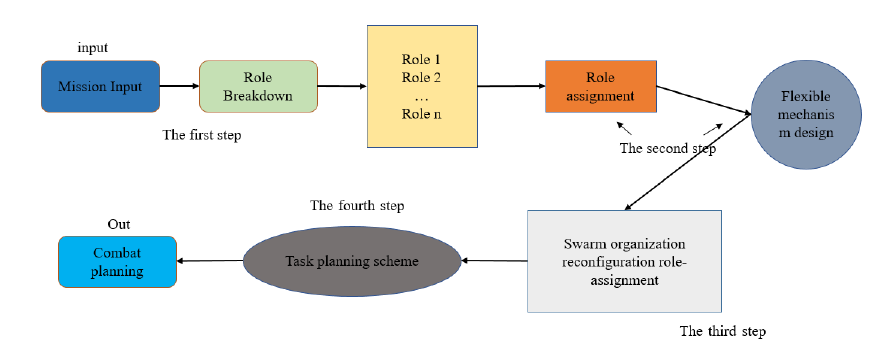
Figure 1. The swarm organization reconfiguration role-assignment planning.